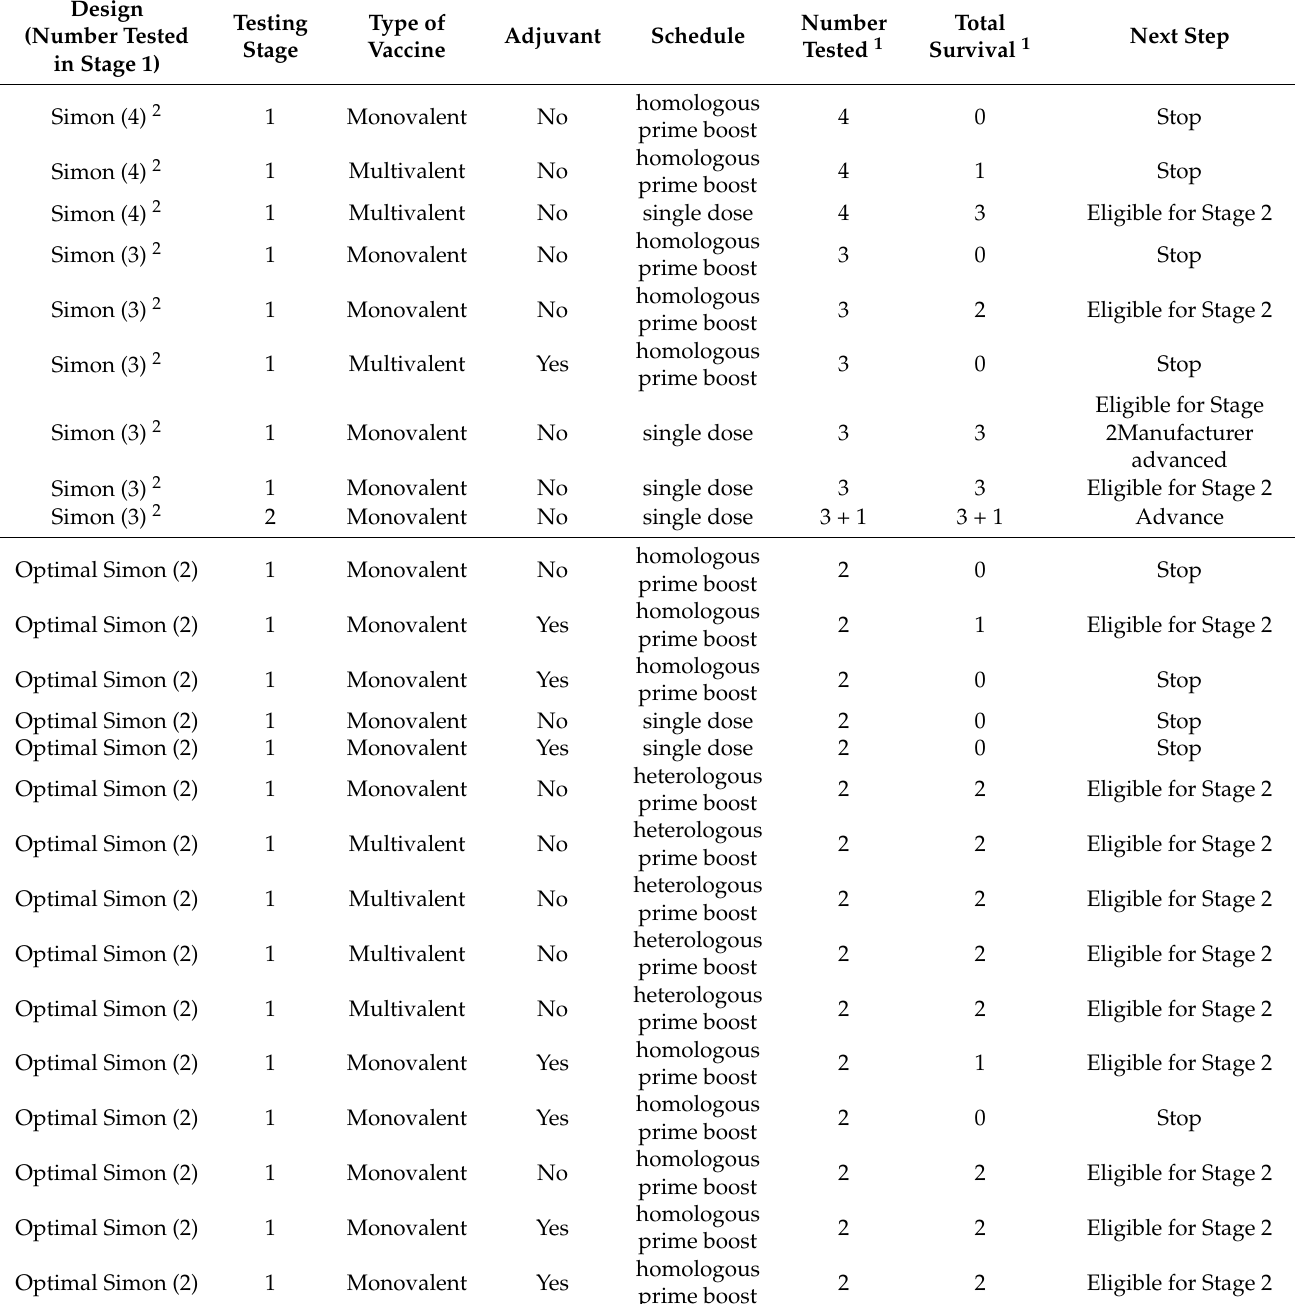
Table 2. Summary of EBOV vaccine candidate regimens tested under the NIAID/DMID preclinical services vaccine screening program between 2012 and 2017 using Simon’s two-stage